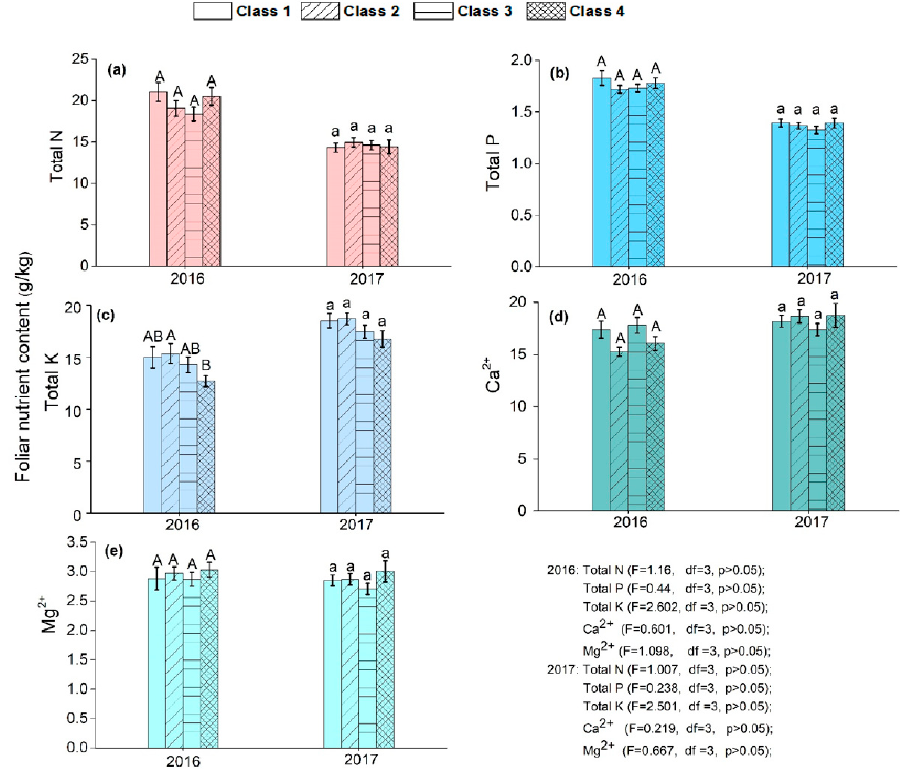
Figure 4. The leaf nutrient contents of total nitrogen ( a ), total phosphorus ( b ), total potassium ( c ), calcium ion ( d ) and magnesium ion ( e ) of trees with different damage rankings in 2016 and 2017. Bars (mean ± SE) with different letters indicate significant difference at P ≤ 0.05. The uppercase “A” and “B” above the bars refer to the difference among four damage rankings in 2016, while the lowercase “a” and “b” refer to the difference in 2017.